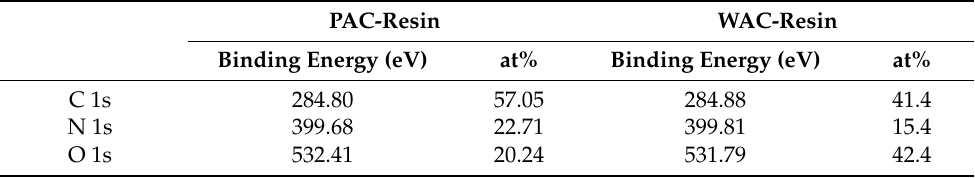
Table 2. C, N and O content and binding energies of the PAC-resin and WAC-resin measured by XPS (at%). PAC-Resin WAC-Resin Binding Energy (eV) at% Binding Energy (eV) at% C 1s